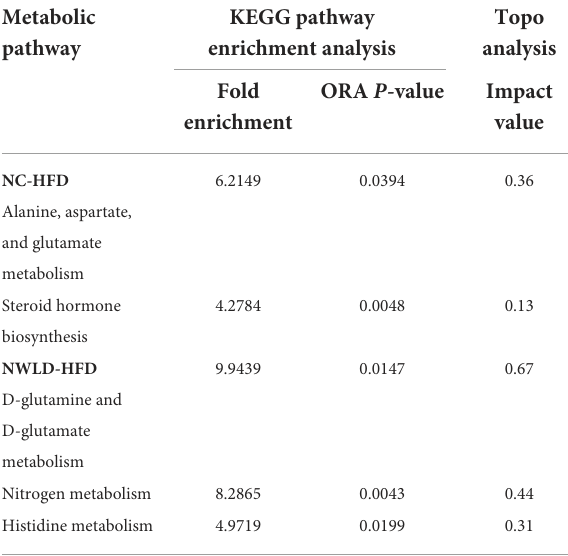
TABLE 3 The metabolic pathways with significant enrichment of differential metabolites between groups and their ORA enrichment analysis and topo